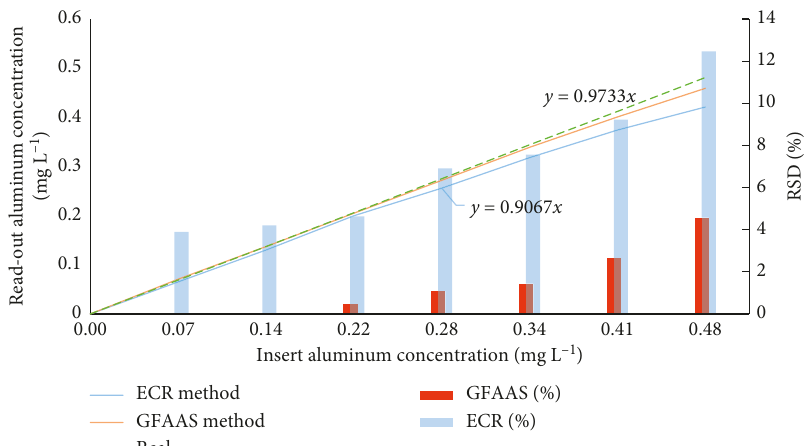
Figure 9: Comparison of GFAAS aluminum concentration determinations and colorimetric method in relation to the actual value.